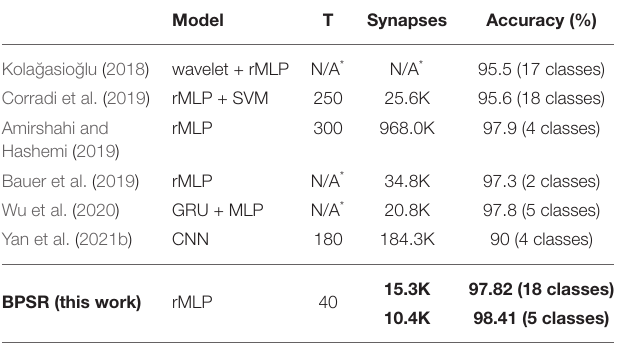
TABLE 6 | Comparison of different spiking models on MIT-BIH